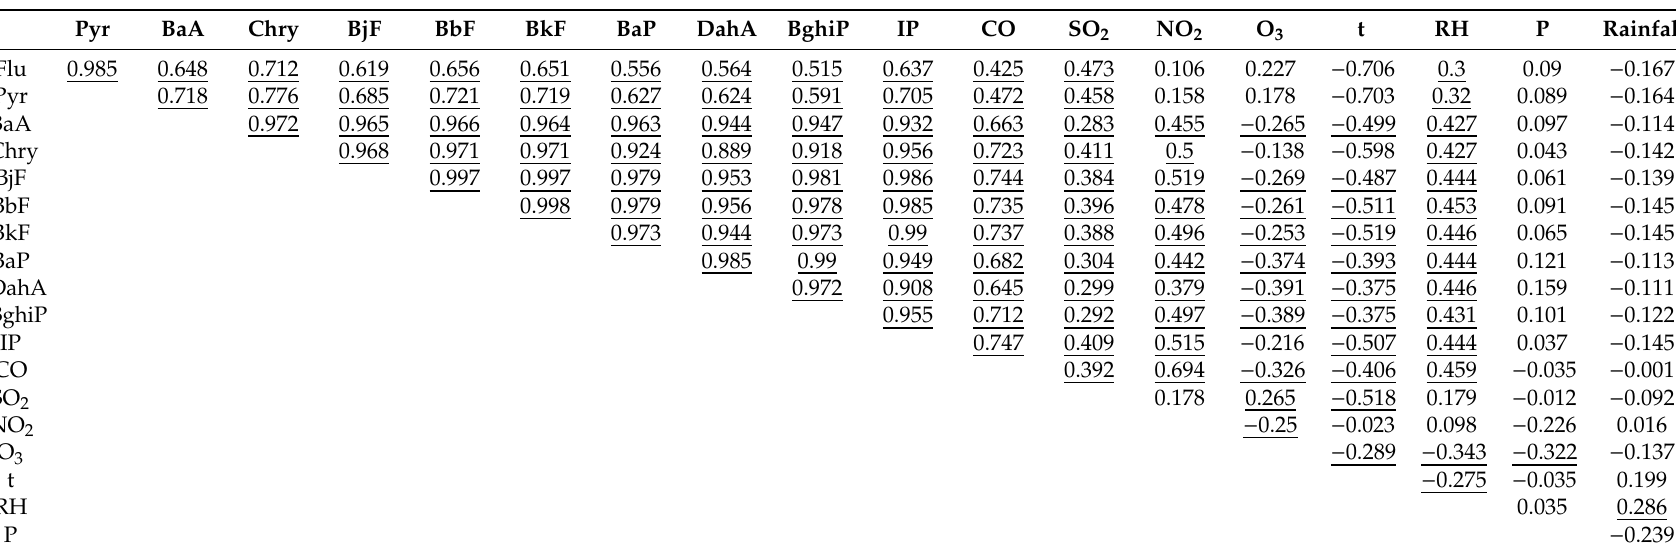
Table 6. Spearman’s correlation coe ffi cients between PAHs, gaseous pollutants, and some meteorological parameters during the cold